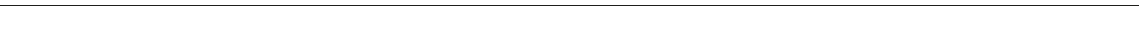
Fig. 2 The GPC areas release Wg to induce wg in the s-IPC. a , b Schematic in a highlights the region of interest shown in subsequent panels. Unlike in controls ( a ), Wg immunolabeling (green) was absent in the s-IPC (dashed line, double arrowhead) in many wg{KO;NRT-wg} fl ies ( b ). The GPC areas (arrowhead) were not affected. c , d In 2nd instar larvae (2L), Wg protein ( c , green) and wg{KO;Gal4} UAS-cd8GFP ( d , green) were detected in GPC areas (arrowhead), but not in the adjacent IPC (dashed line). e , f s-IPC-speci fi c wg{KO;Gal4} UAS-cd8GFP expression (green, double arrowheads) in mid 3rd instar larvae ( e ) was absent in wg{KO;NRT-wg} fl ies ( f ). Arrowheads indicate expression in GPC area. g , h In controls, wg{KO;Gal4} UAS-FLP mediated wg{KO;FRT wg + FRT NRT-wg} allele switching and simultaneous UAS-NRT-wg overexpression were induced at the mid 3rd instar larval stage ( g , wg + background). Allele switching at the 1st instar larval stage ( h , NRT-wg background) did not rescue s-IPC-speci fi c Wg loss (green). i , j Unlike in controls ( i ), R46E01-Gal4 UAS-FLP- mediated GPC areas-speci fi c wg{KO;FRT NRT-wg FRT wg + } allele switching ( j ) rescued s-IPC-speci fi c NRT-Wg loss (green). Filled and open triangles in transgene schematics represent FRT and loxP sites, respectively ( g – j ). k , l The Wg target gene reporter lines fz3 G00357 -GFP ( k , green) and notum WRE -lacZ ( l , green) show expression in the GPC areas, the s-IPC, and in migratory progenitors (arrow) originating from the adjacent p-IPC. m , n Unlike in controls ( m ), fas3 NP1233 -Gal4 -mediated IPC-speci fi c fz and fz2 knockdown ( n ) caused loss of Wg (green) in the s-IPC. o Summary of wg function in the GPC areas. For genotypes and sample numbers, see Supplementary Table 1. Scale bars, 50 μ